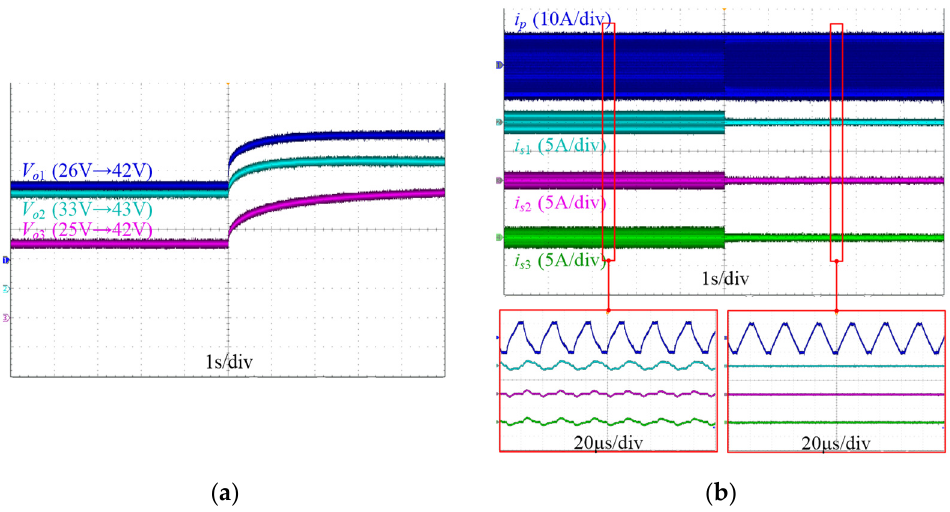
Figure 15. Experimental waveforms under open-circuit conditions. ( a ) Waveforms of the output voltages. ( b ) Waveforms of the current transformers. voltages. ( b ) Waveforms of the current